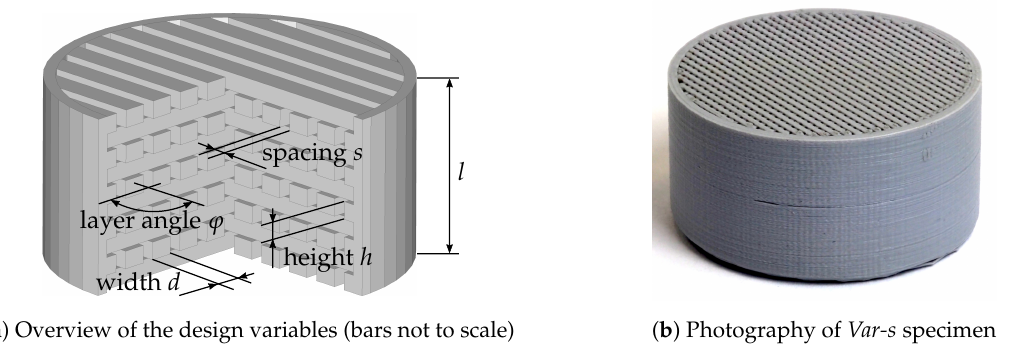
Figure 1. Geometric design (left, CAD model; right, photography) of investigated 3D-printed